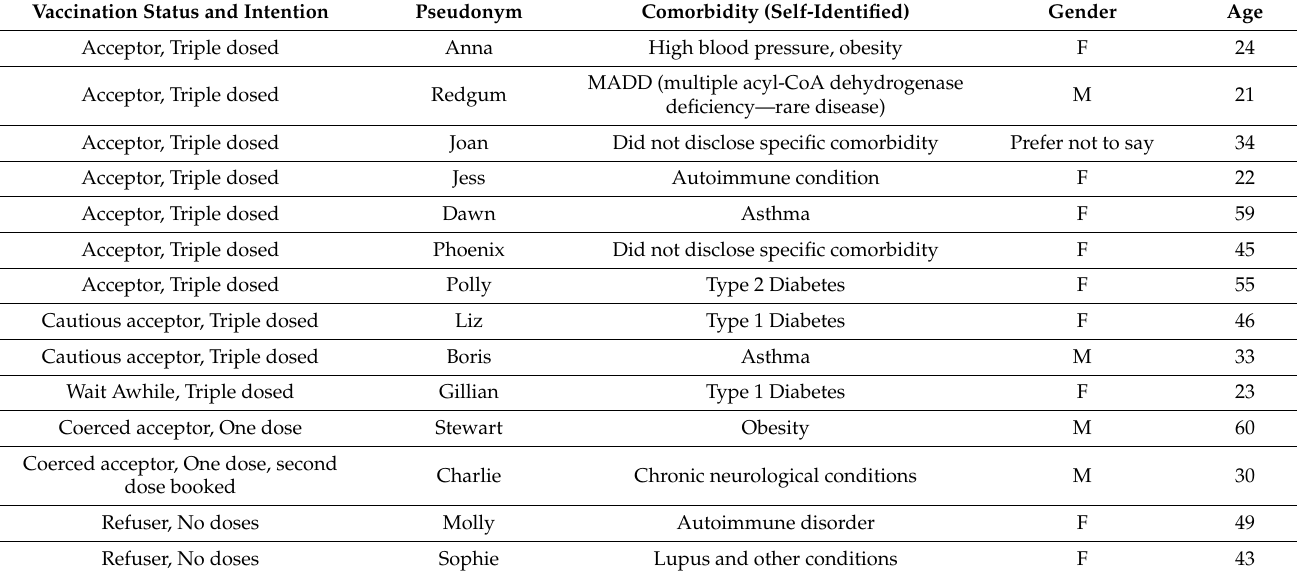
Table 1. Demographic details of